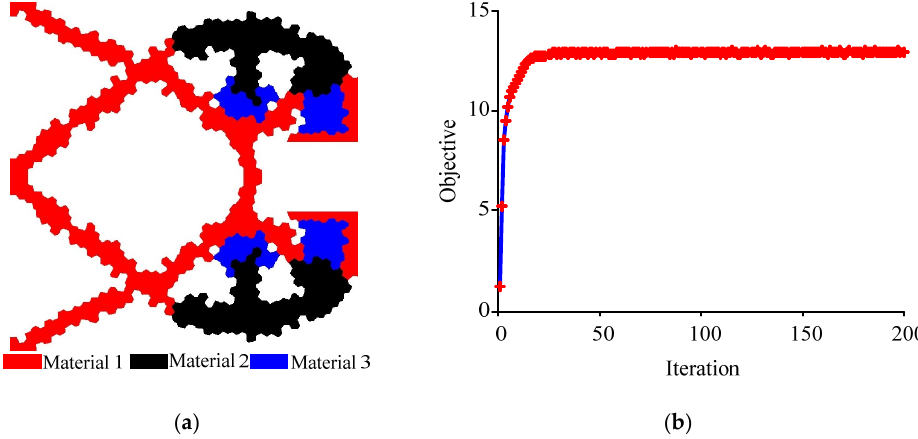
Figure 12. Optimization results of gripper case 3: ( a ) Identifed topologies; ( b ) convergence plot.